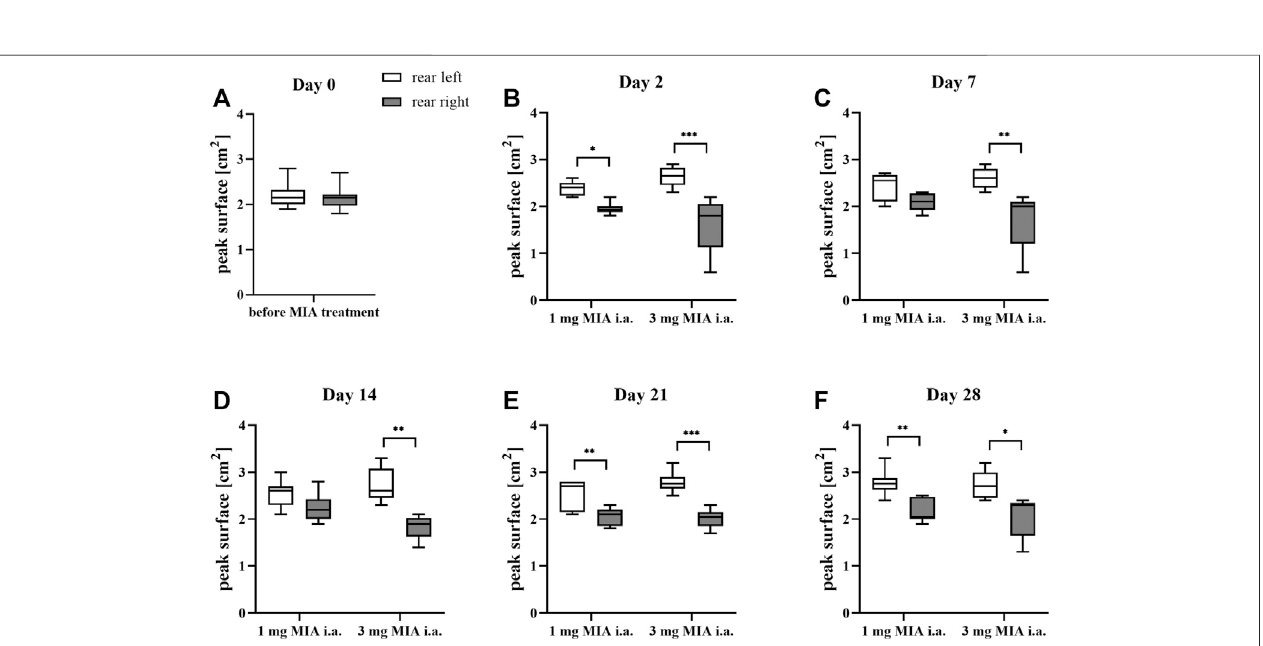
FIGURE3| GaitanalysisinOAratsrecordedwithKWBbymeasuringthedistributionofpawsurfacesappliedtothegroundduringfreewalks(for1and3 mgofMIA i.a. groups) during a free walk. Measurements taken prior to the MIA injection (day 0; A ) and 2, 7, 14, 21, and 28 days (B – F) post MIA treatment (n (cid:2) 5 – 8 animals per group). One-way ANOVA on day 0 or two-way ANOVA on the following experimental days and Tukey ’ s HSD post hoc test were performed. * denotes p < 0.05; ** denotes p < 0.01; *** denotes p < 0.001.